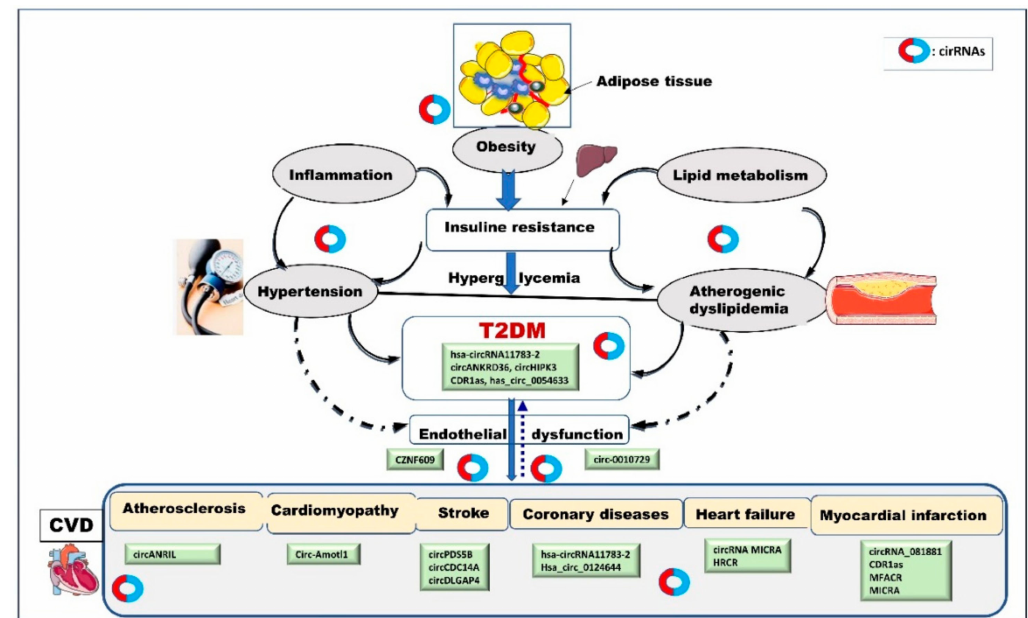
Figure 1. The possible pathogenic mechanisms linking diabetes to cardiovascular diseases. In addition to common genetic and environmental factors, epigenetic regulatory mechanisms such as circRNA transcripts are also postulated to play a direct or indirect role in diabetes and related cardiovascular complications. As illustrated in this figure, circRNAs may have a complex regulatory capacity in di ff erent stages of development in diabetes and CVD. Under various triggers, circRNAs (produced from local tissue or coming from the circulation) may contribute to the development of risk factors including obesity, inflammation, hypertension, hyperlipidemia, and insulin resistance, modulating diabetes progress and associated vascular disorders. circRNA transcripts may also act as a platform connecting T2DM and CVD and could be potentially used as biomarkers to predict CV outcomes in diabetes state. Cardiovascular tissues may, in turn, release circRNAs that enter a vicious cycle exacerbating diabetes, hypertension, and other